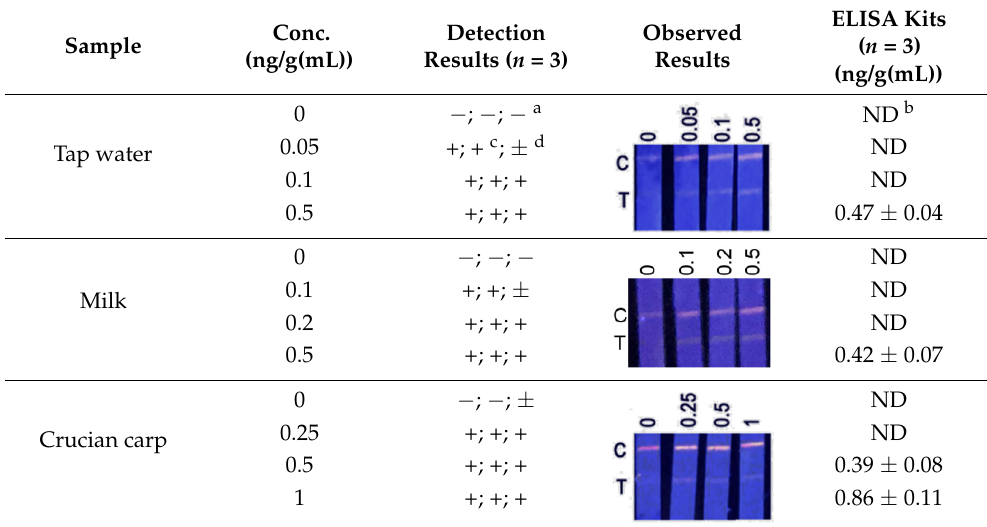
Table 2. Comparison of the developed FISs and the commercial ELISA kit for the detection of ENR in tap water and crucian carp samples. Conc.